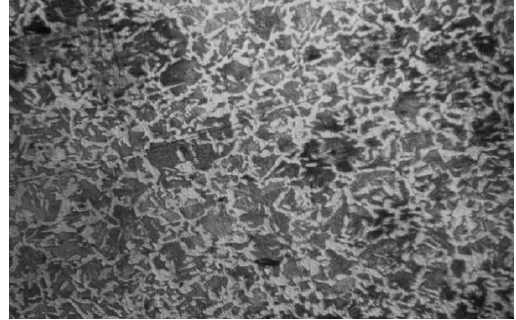
Fig.1. The structure of the base metal of steel 45